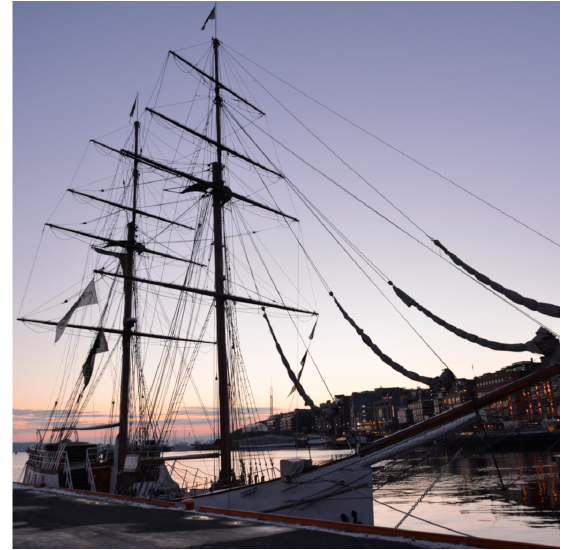
Figure 4. Harbour in sunset, taken by the first author. The fine details of the deck and the buildings are hidden in the